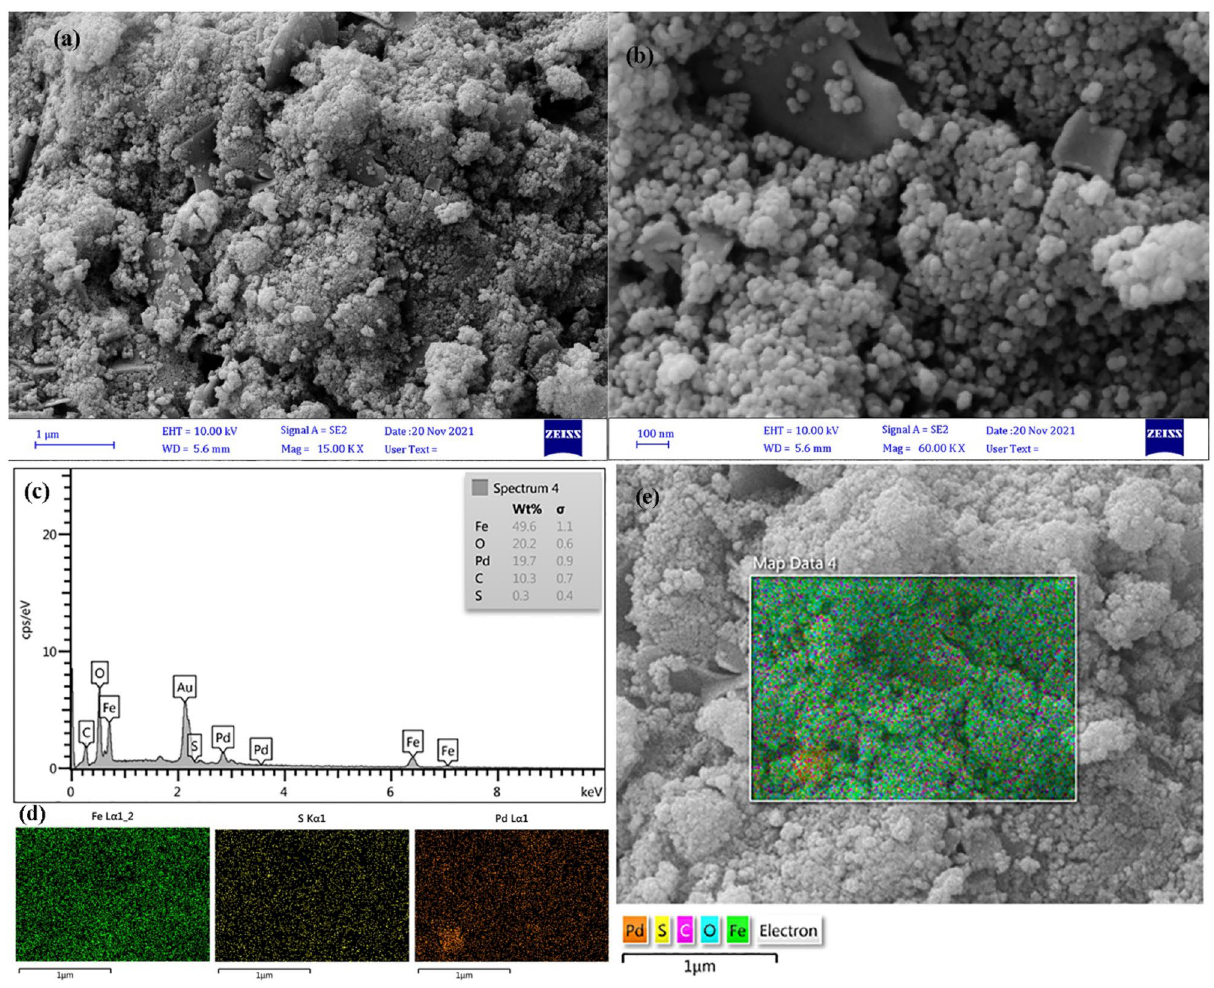
Figure 3. ( a,b ) SEM images of Pd@m FuVe NPs catalyst in different magnifications; ( c ) EXS; and ( d,e ) SEM mapping of Pd@m FuVe NPs catalyst.